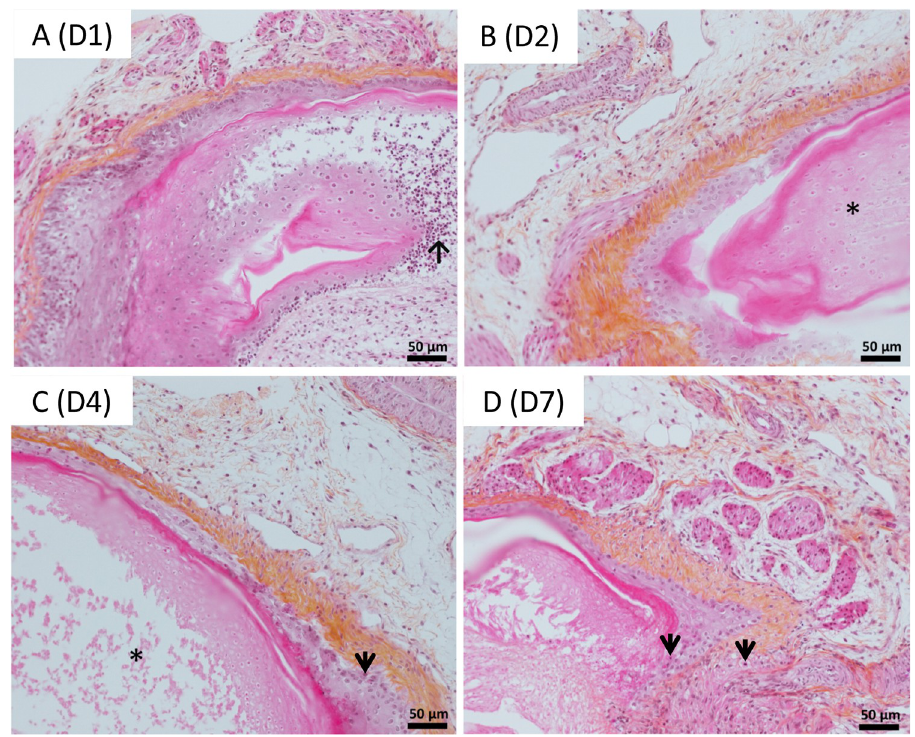
Fig 4. Example of lesions observed in the cultivated FF from 1 to 7 days. The black arrows indicate pyknotic nuclei. The asterisks ( � ) indicate necrotic feather pulp without viable cells visible (incl. “ghost” cells at Day 2).